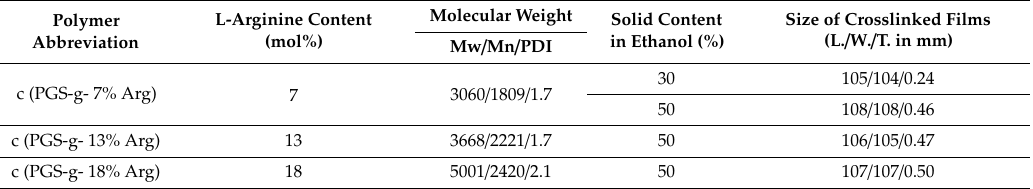
Figure 1. The preparation schemes of ( A ) poly(glycerol sebacate) (PGS) prepolymer, ( B ) PGS-g-Arg polymer, and ( C ) PGS-g-Arg crosslinked films (c(PGS-g-Arg)). Table 1. Molecular compositions and characteristics of prepolymers and crosslinked films.